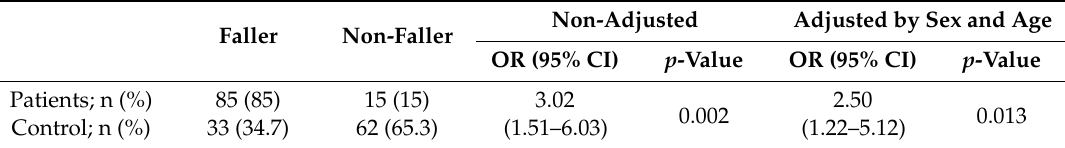
Table 2. Odds ratio calculations for being a faller or non-faller, NMOSD patients versus healthy controls. Non-Adjusted Adjusted by Sex and Age Faller Non-Faller OR (95% CI) p -Value OR (95% CI) p -Value Patients; n (%) 85 (85)